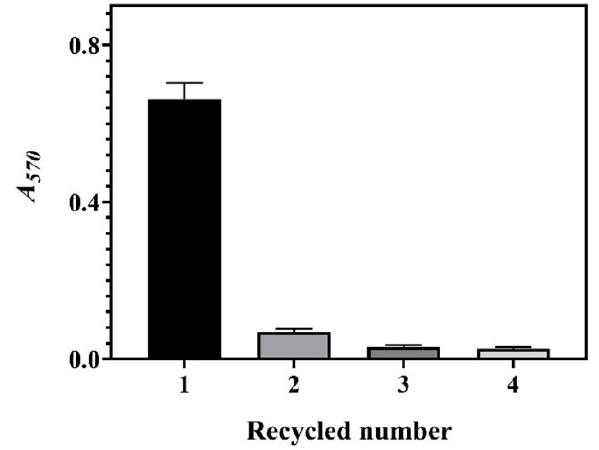
Figure 5. GABA productions of four sequential runs of the whole-cell catalysis system. The relative content of GABA is expressed as A 570 ( n = 3). A 570 , absorbance at 570 nm.